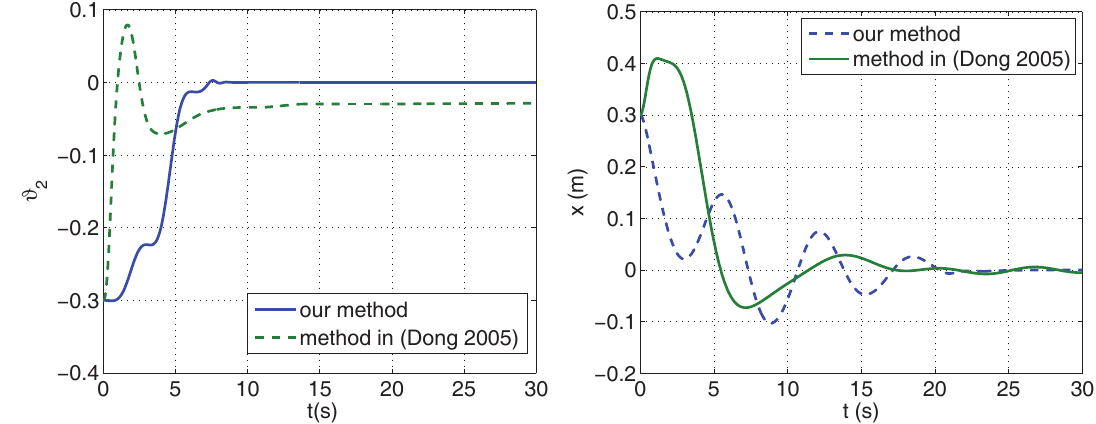
Figure 3. Comparison of the state ϑ 2 and x -coordinate position of this paper and [12].